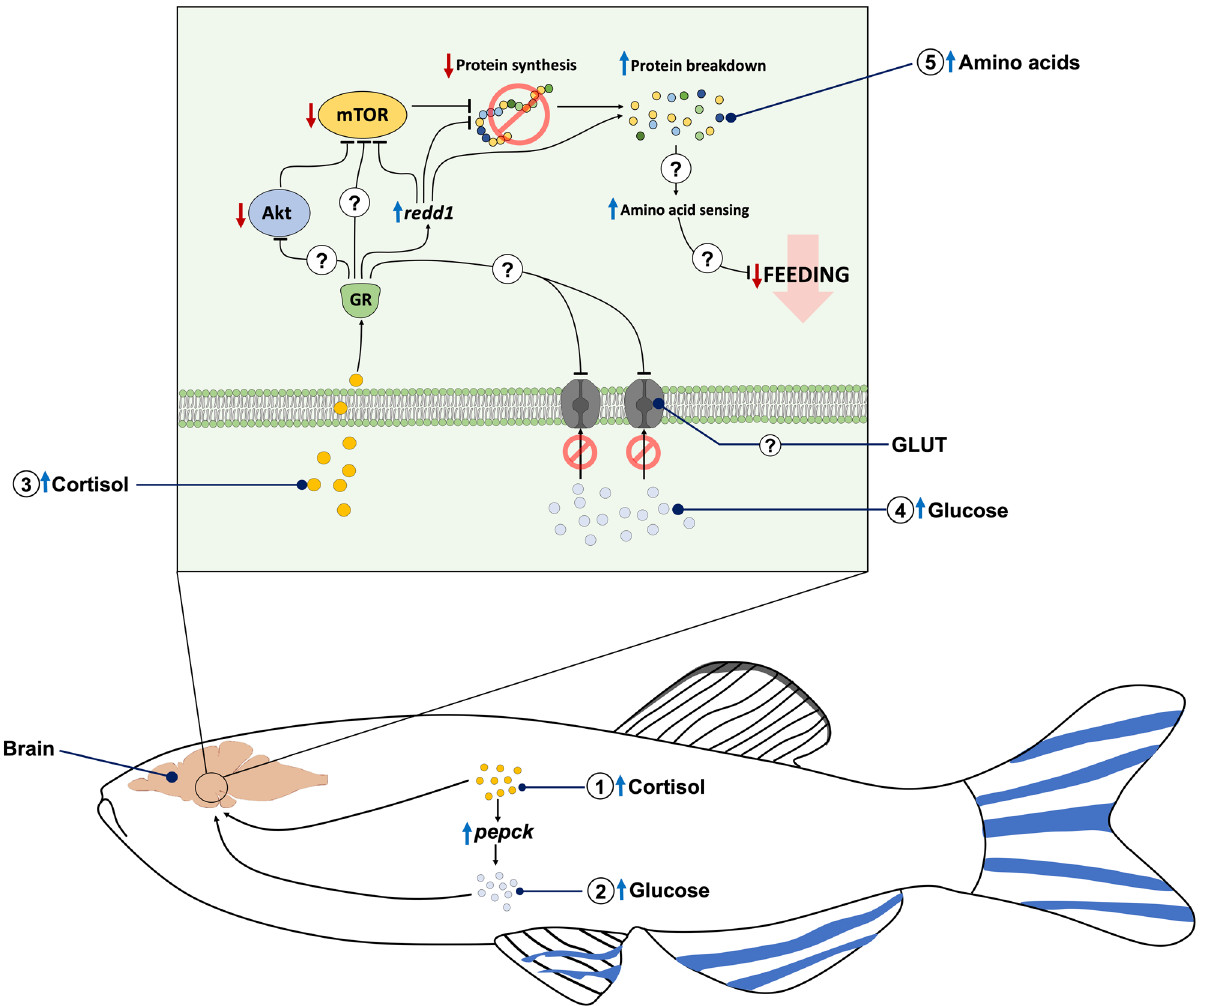
Figure 10. Schematic representation of cortisol action on the regulation of feeding in zebrafish. Hypercortisolemia increased liver pepck transcript abundance suggesting enhanced capacity for gluconeogenesis (1), leading to elevated blood glucose levels (2). The elevated cortisol levels activate the glucocorticoid receptor (GR) in the brain (3), which restricts brain glucose uptake (4). GR activation increased redd1 transcript abundance and decreased the Akt-mTOR signaling, suggesting enhanced capacity for protein catabolism in the brain. We propose that increased protein breakdown may elevate the amino acids pool in the brain and alter the central amino acid sensing (5), which plays a role in the feeding/appetite suppression. “?” denotes mechanism and rainbow trout ( Oncorhynchus mykiss ) proposed that slc2a2 may be involved in brain glucose sensing, as it plays an essential role in brain development by facilitating glucose uptake and availability 57–59 . In the GRKO fish, unlike the fish treated with glucose, the increased capacity for glucose uptake in the brain did not correspond with a reduction in the phosphorylation of AMPK. While the reason for this is unclear, it may have to do with the positive energy status, given the enhanced capacity for brain glucose uptake and protein synthesis. This notion is supported by the higher brain mass and protein content in the GRKO fish in the present study. Also, a faster growth and a higher capacity for protein synthesis and lipid accumulation in the GRKO fish underscores an efficient energy utilization 8,24 , leading to a lower food intake. As redd1 regulates mTOR 23,25,60 , the reduced transcript abundance of redd1 in the GRKO fish may also favour mTOR phosphorylation and higher protein synthetic capacity. Consequently, the suppression of mTOR signalling by GR either directly and/or indirectly via redd1 regulation may play a role in cortisol-mediated protein synthesis inhibition. In conclusion, high cortisol levels, and stress-independent hyperglycemia, reduced feeding in zebrafish but through distinct mechanisms (See Fig. 10). Despite a hyperglycemic phenotype in both instances, GR activa- tion by cortisol restricted brain glucose uptake and did not alter the phosphorylation of AMPK, unlike stress- independent hyperglycemia, which reduced phosphorylation of this nutrient sensor. The lack of change in AMPK due to cortisol may be associated with an enhanced capacity for brain proteolysis, and the associated increase in amino acid levels. The cortisol-driven changes, including upregulation of redd1 and the suppression of mTOR